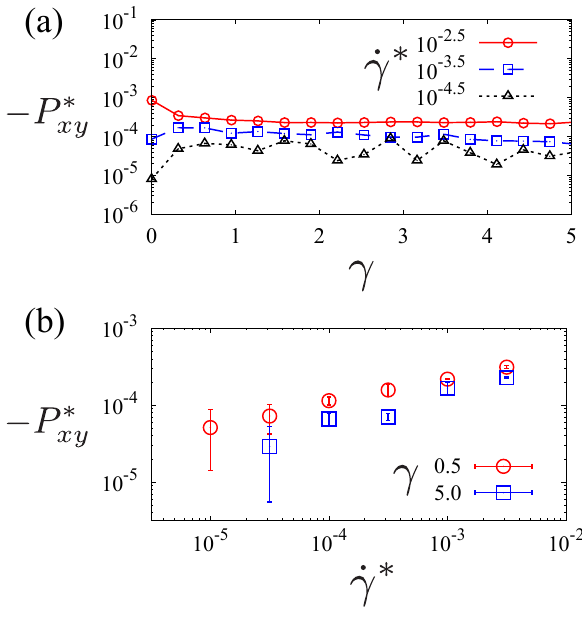
Figure 6. (a) Evolution of the dimensionless shear stress P ∗ P x y / k n as a function of the shear strain γ for ˙ γ ∗ = 10 − 2 . 5 (open circles), 10 − 3 . 5 (open squares), and 10 − 4 . 5 (open triangles). (b) Plot of the shear stress against the shear rate with the shear strain γ = 0 . 5 (open circles) and 5 . 0 (open